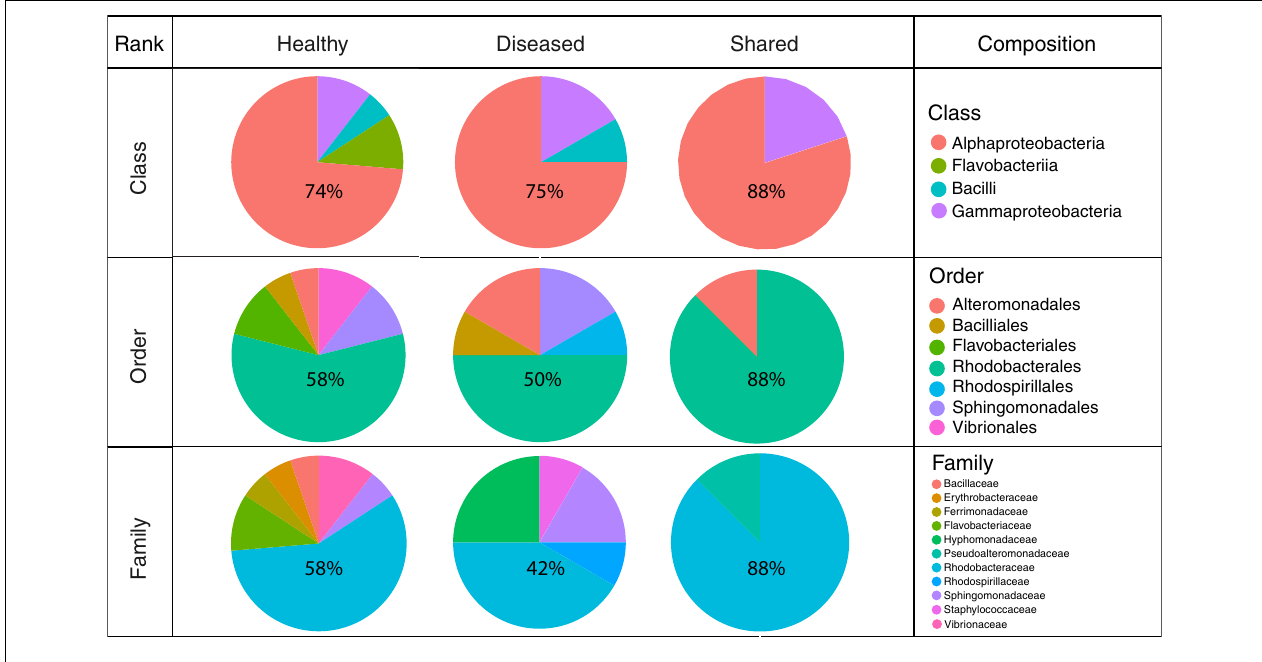
FIGURE 6 | Cultured bacterial composition at the class, order, and family levels for isolates obtained from healthy-looking tissue, diseased tissue and both.